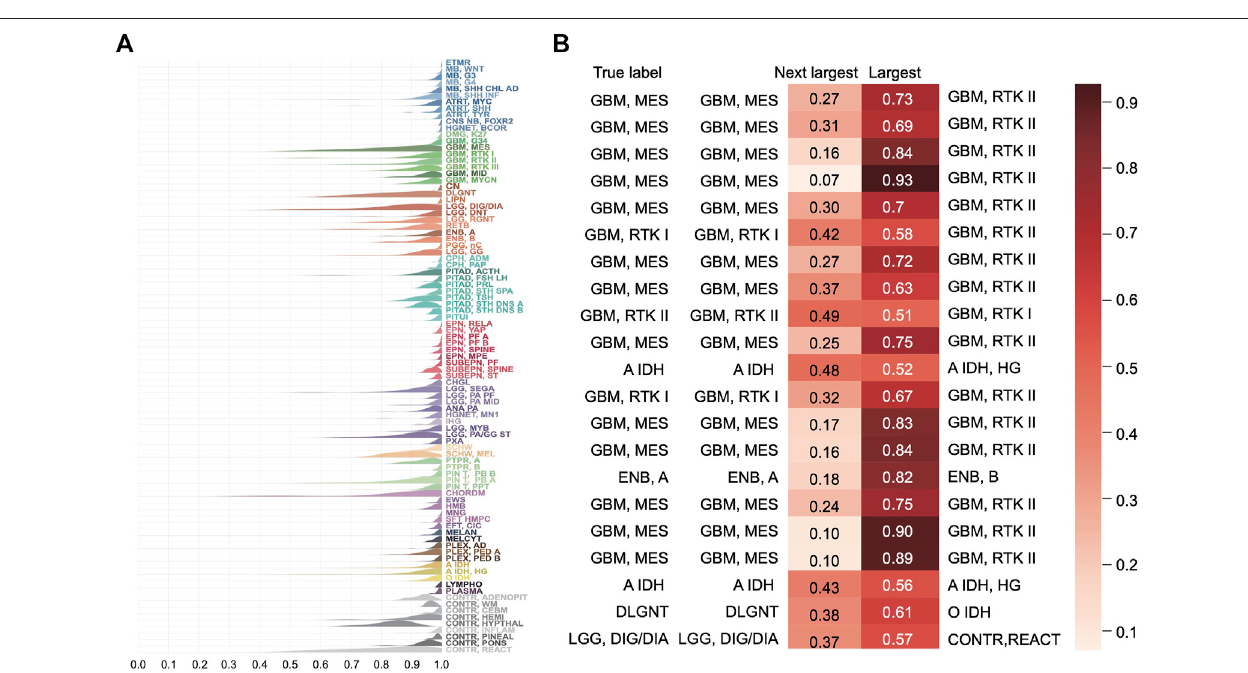
FIGURE5| Distributionofthepredictedscoresforeachclassinthetrainingset. (A) Eachrowrepresentsaprobabilitydensitycurveofthepredictedscoresforeach classtowhichthesamplesbelong.Theheightsofcurveswerenormalized. (B) Thepredictedscoresofthetrueclassesandthelargestpredictedscoresoftheincorrectly classi fi ed samples in the training set.